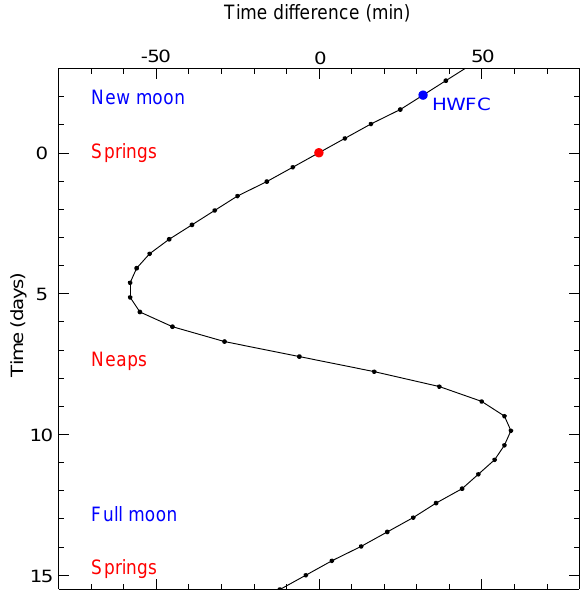
Figure A1. The lag between the passage of the moon across the local meridian and the next high water, compared to the average lag over a spring–neap cycle, assuming a magnitude for the semidiurnal solar tide (S2) relative to semidiurnal lunar tide (M2) of 0.46. The red and blue dots show the lags at spring high water and at new moon respectively, while time zero is chosen to be at spring tides. Adapted from Fig. 3.14 of Pugh and Woodworth